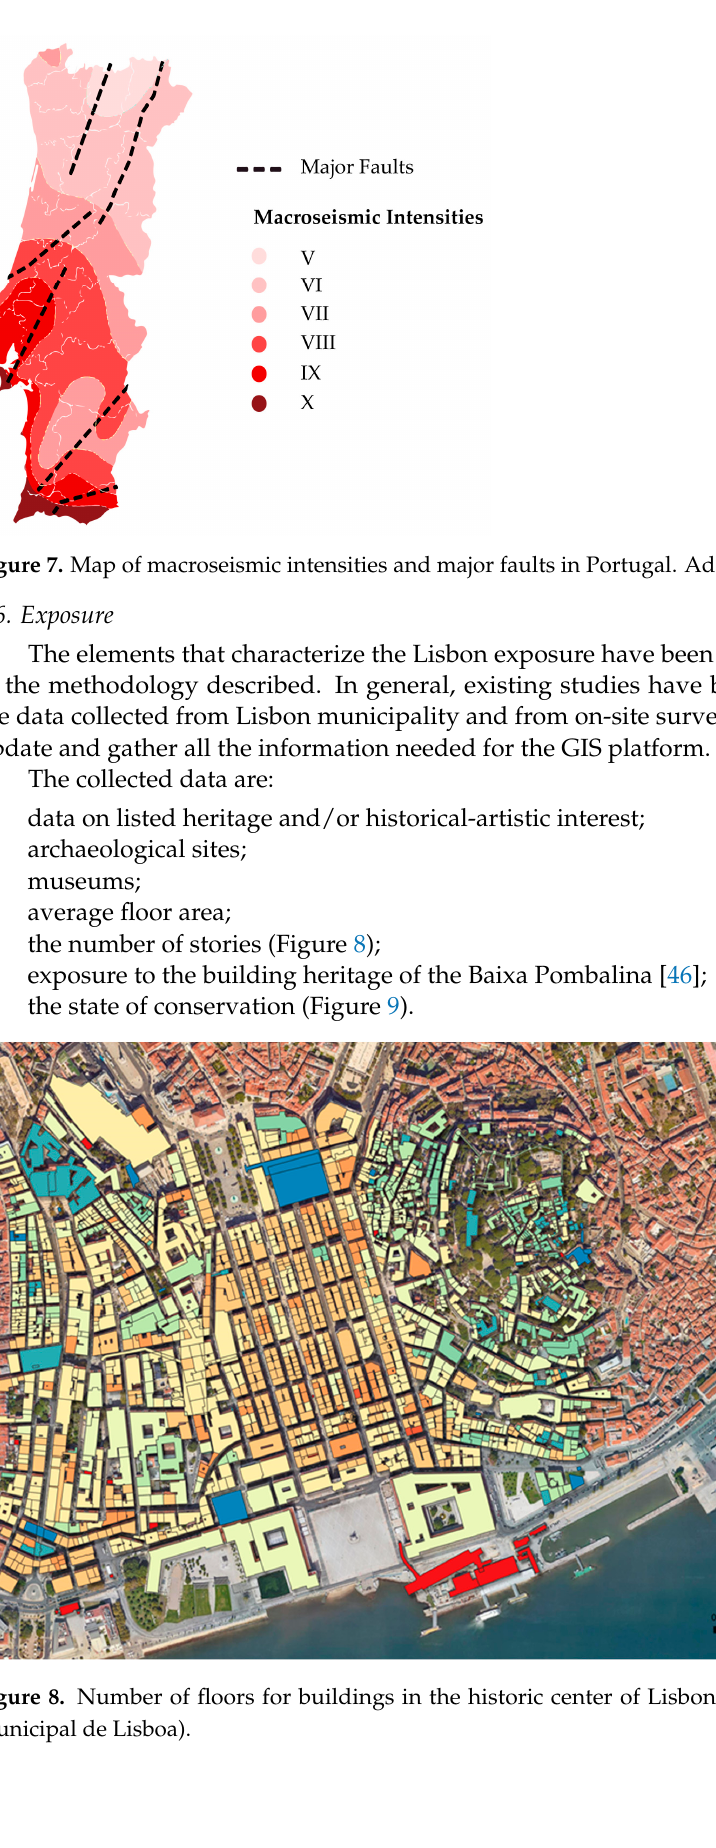
Figure 9. State of conservation of the buildings in the historic center of Lisbon (Camara Municipal de Lisboa, revised through on-site surveys in 2022 by the authors). 3.7. Vulnerability Assessment for the Historic Center of Lisbon From all the information obtained from the research data implemented above, it was possible to obtain all the information necessary to assess the seismic vulnerability of the buildings in the historic center of Lisbon. Two simplified assessments were performed: